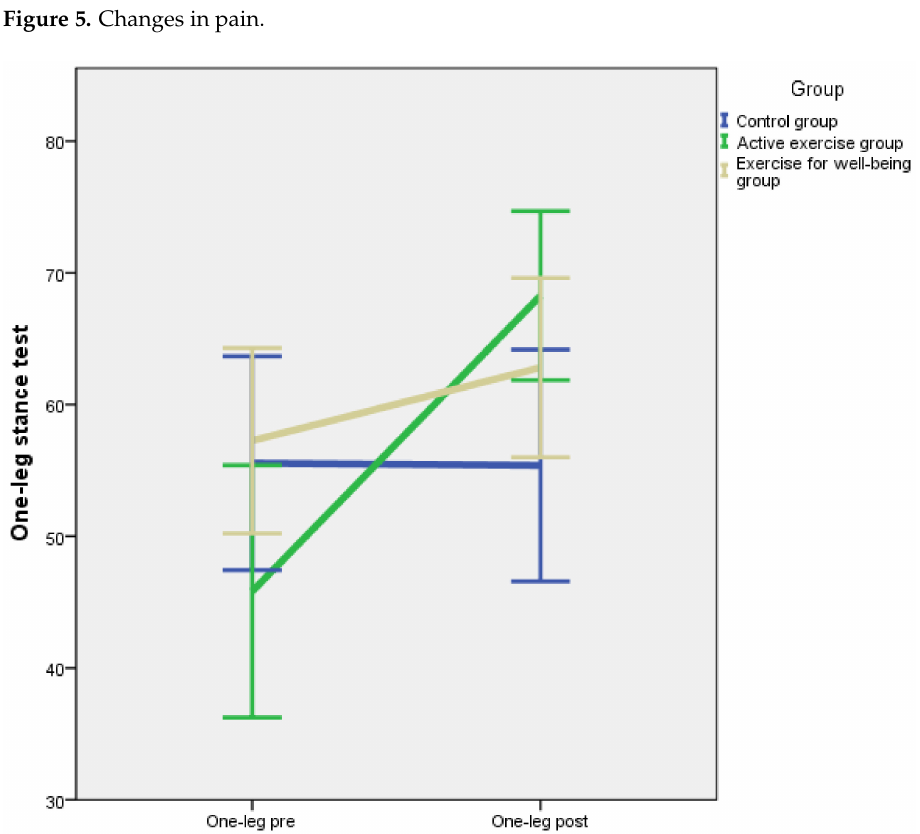
Figure 6. Changes in the one-leg stance